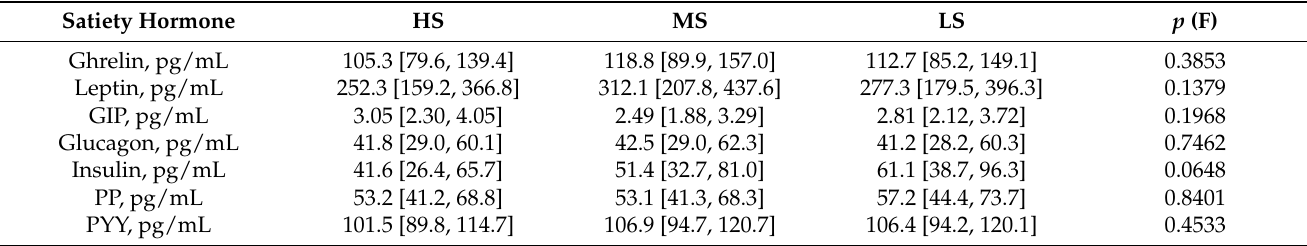
Table 4. Estimated mean concentration (and [95% confidence interval]) of satiety hormones in plasma of fasting dogs ( n = 23) fed diets produced at high, medium, and low shear (HS, MS and LS, respectively). Satiety Hormone HS